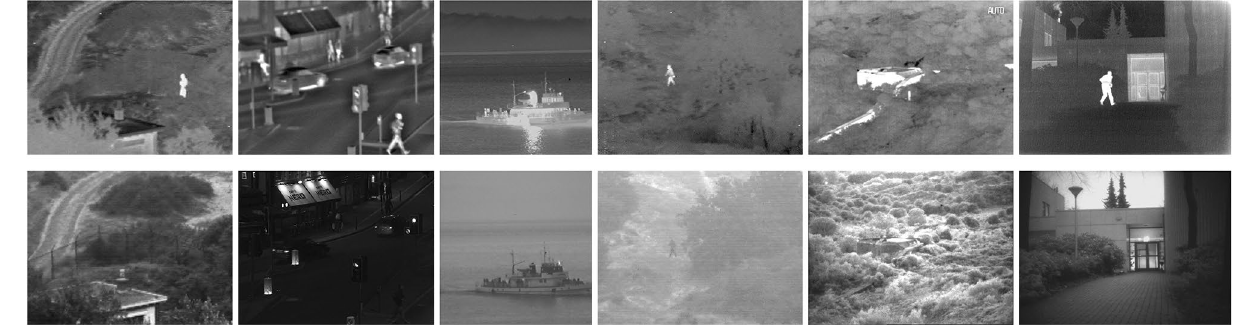
Figure 5. Portion of test images used in our